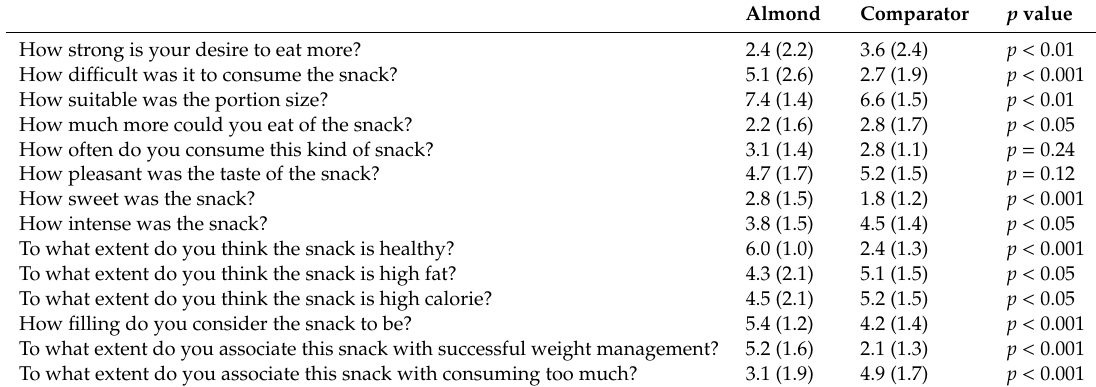
Table 4. Mean (SD) palatability and perception ratings for the almond and comparator snack.